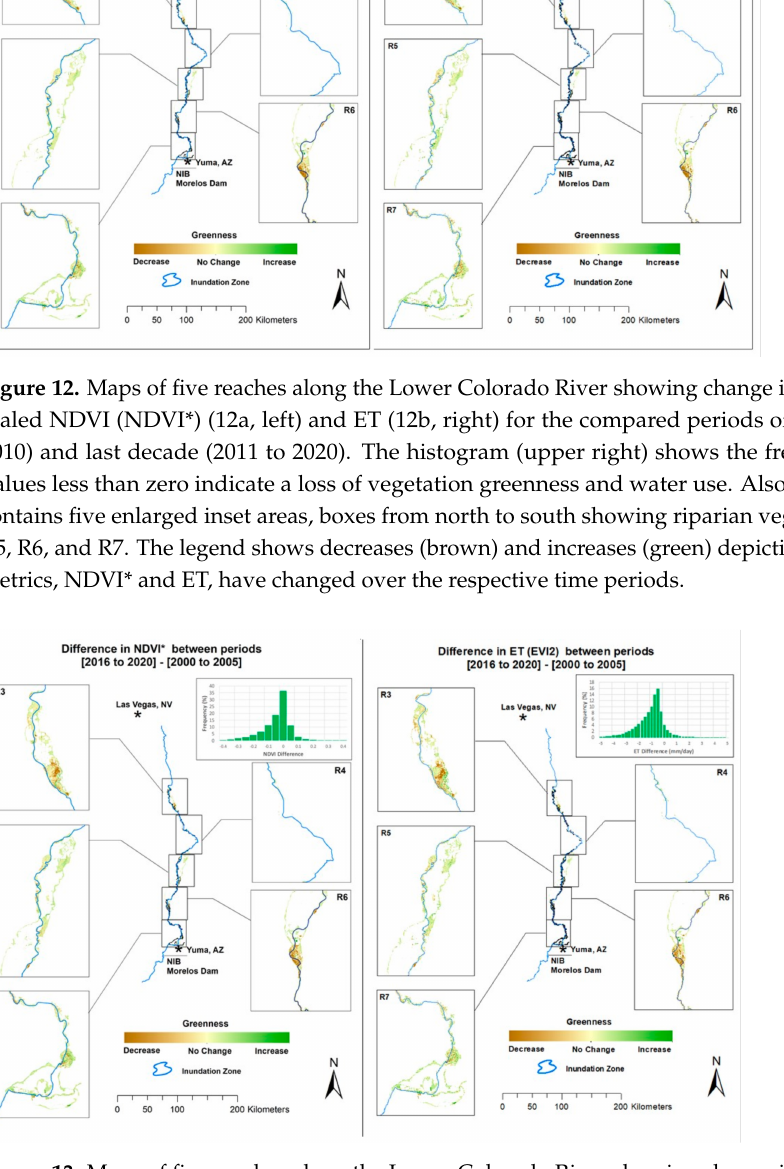
Figure 13. Maps of five reaches along the Lower Colorado River showing change in greenness using scaled NDVI (NDVI*) (13a, left) and ET (13b, right) for the compared periods of the first (2000 to 2005) and last decade (2016 to 2020). The histogram (upper right) shows the frequency of pixels. Values less than zero indicate a loss of vegetation greenness and water use. Furthermore, each map figure contains five enlarged inset areas, boxes from north to south showing riparian vegetation in R3, R4, R5, R6, and R7. The legend shows decreases (brown) and increases (green) depicting how these two metrics, NDVI* and ET, have changed over the respective time